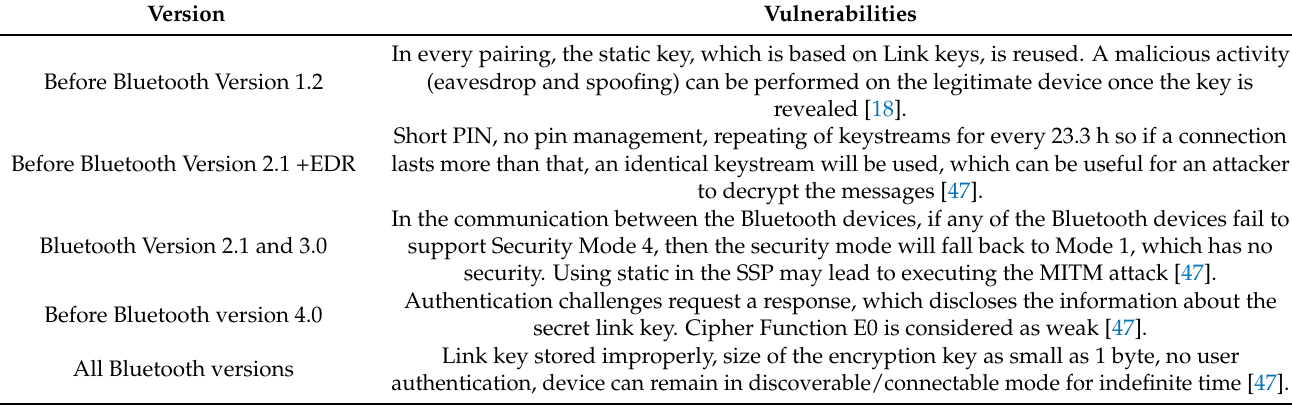
Table A1. Bluetooth